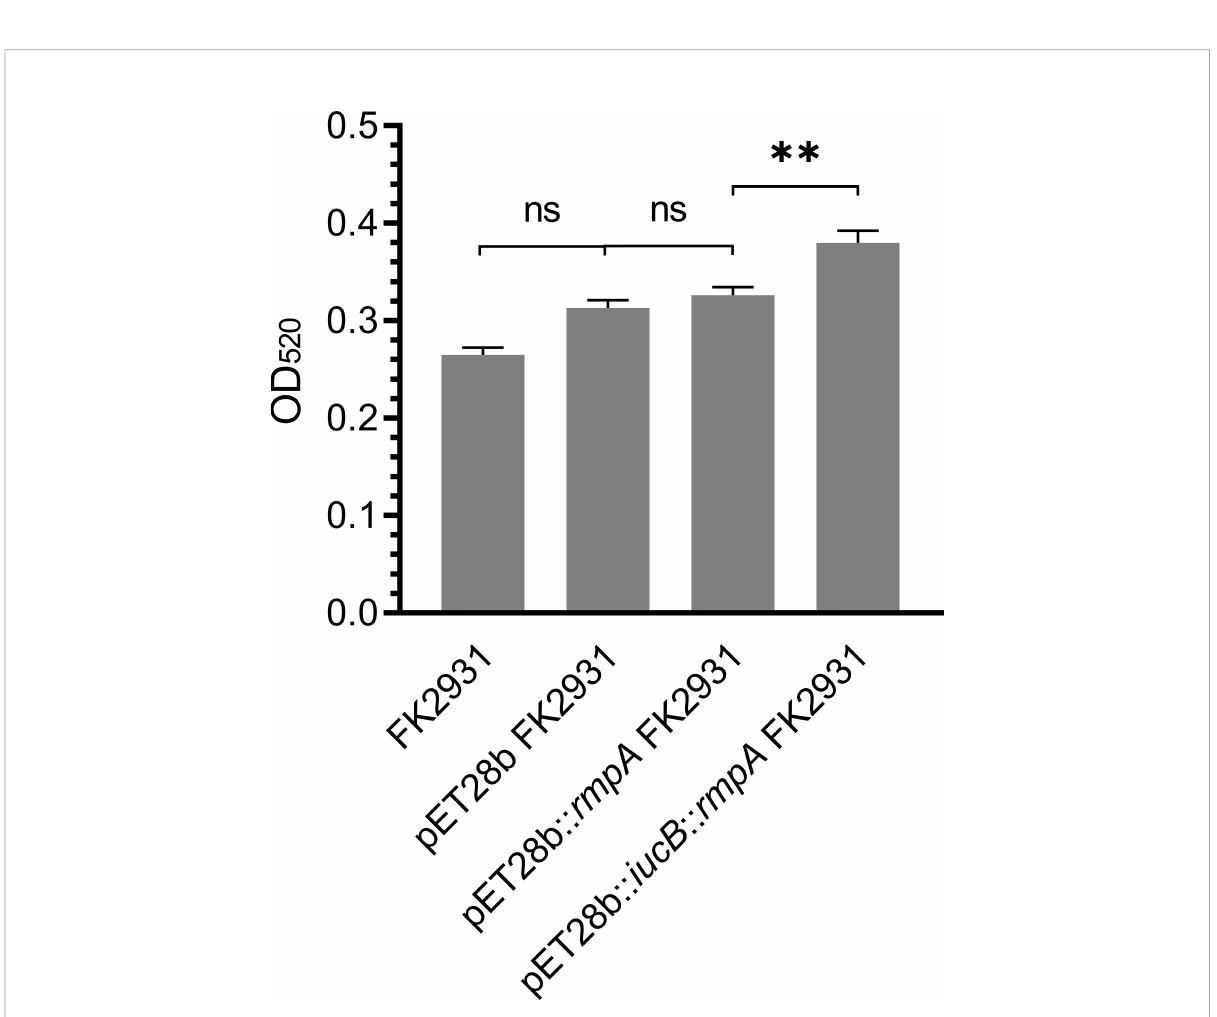
FIGURE 2 Capsule Quanti fi cation Experiment. ** indicates a statistical difference. ns means no statistical difference.